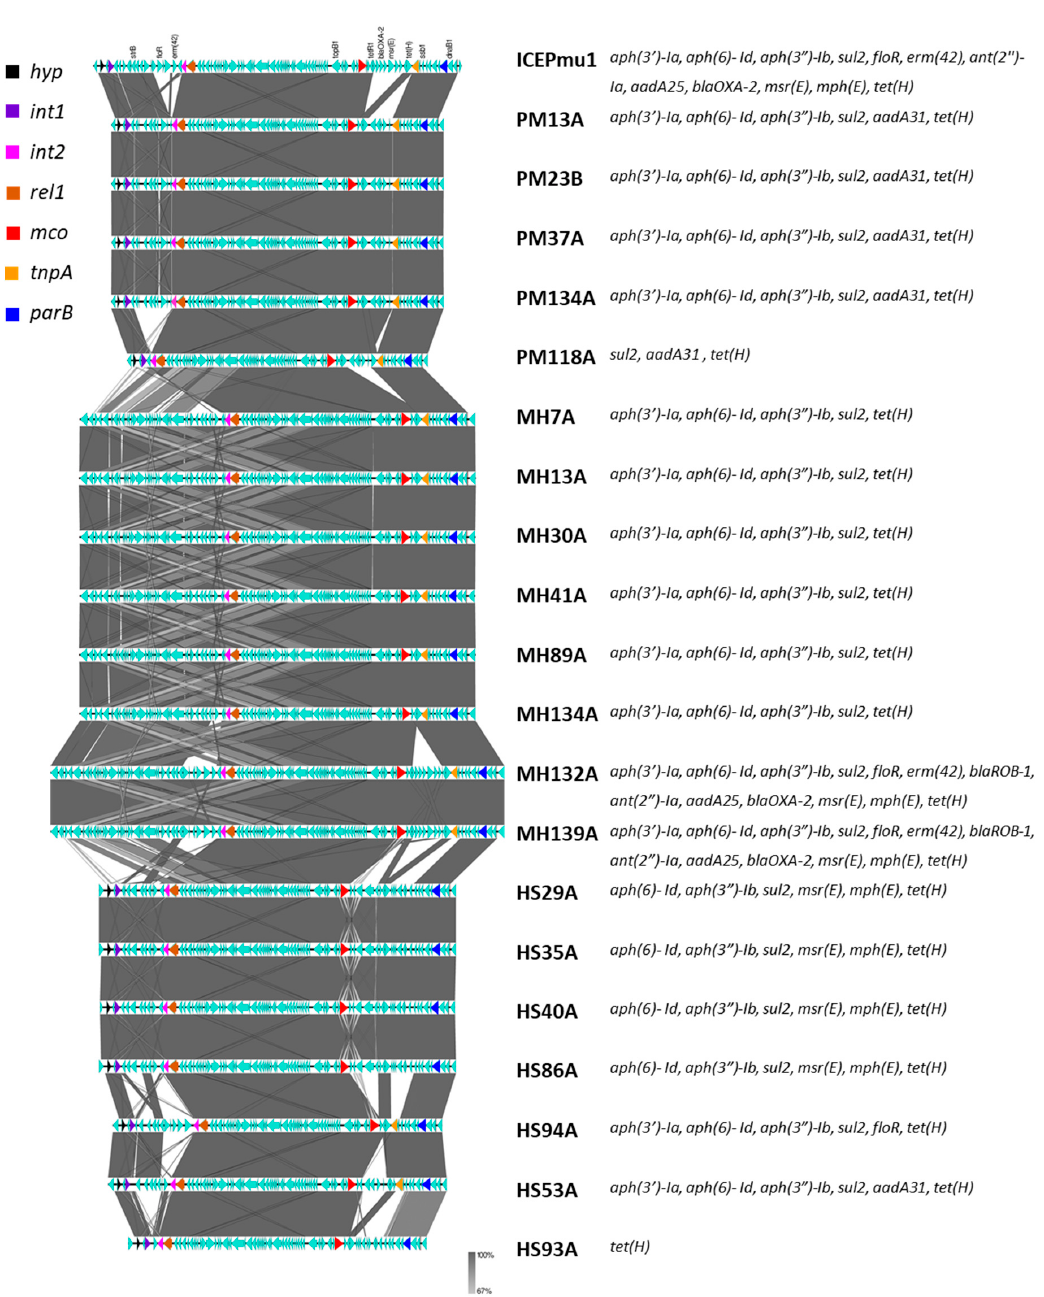
Figure 1. Schematics and homology of the ICE region in Pasteurellaceae species isolates determined by whole-genome sequencing [28]. Five ICE-related genes— hyp , int1 , rel1 , mco and tnpA —were employed in this study to identify ICE using PCR are indicated. Two addition ICE-related genes int2 and parB found to be conserved among the ICE-containing isolates of MH, PM and HS are also marked. Most conserved genes present in the ICE region in sequenced isolates had 100% nucleotide sequence identity across three